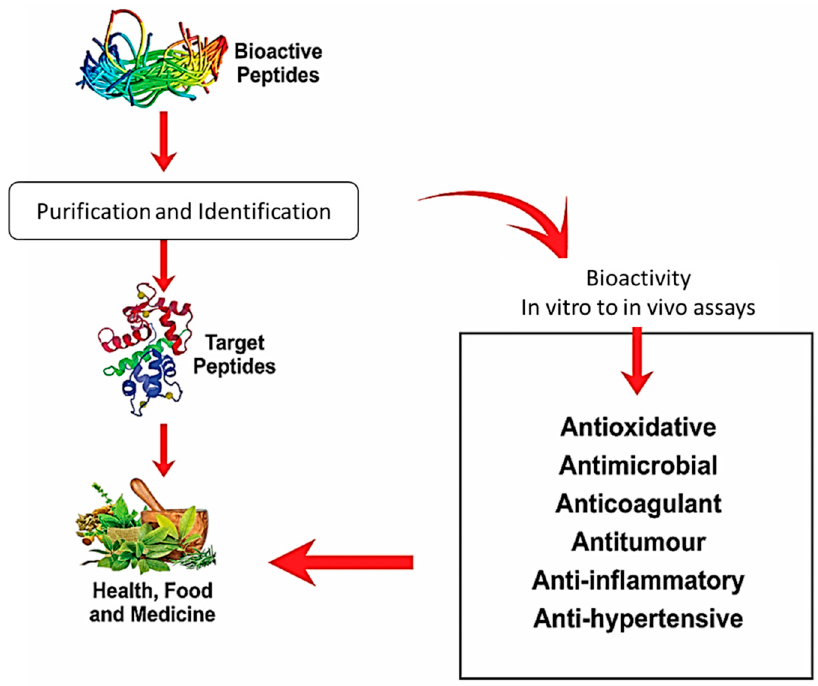
Figure 1. Bioactive peptides and associated health benefits, where attributed to their physiological activities exerted in vitro and in vivo, these include lowering blood pressure by inhibiting the angiotensin-converting enzyme (ACE); oxidative stress reduction by neutralizing or scavenging free radicals; antimicrobial (targeting binding efficacy towards the pathogen cell wall), anticoagulant, antitumor (targeting cancer cells), and anti-inflammatory (triggering the anti-inflammatory cytokines).